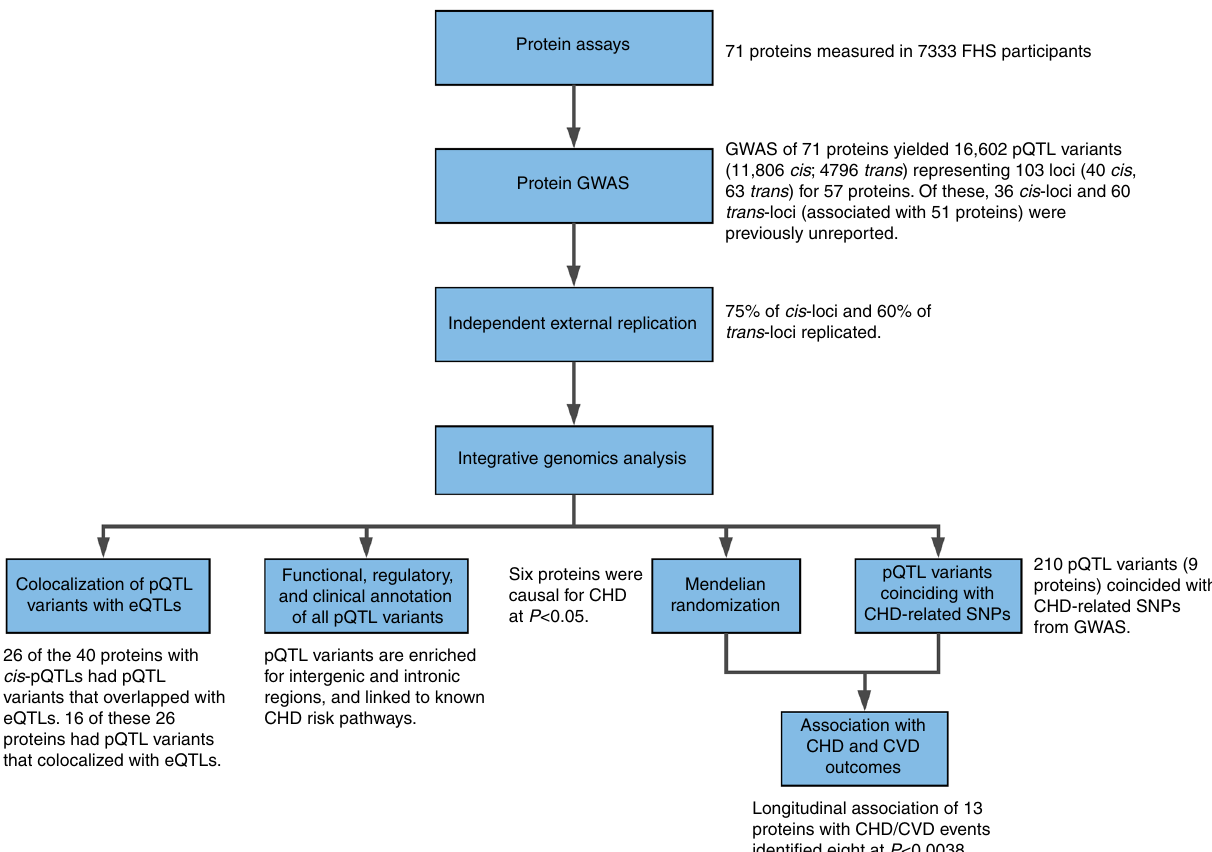
Fig. 1 Flowchart of Study Design. (1) Selection and measurement of 71 high-value plasma proteins for atherosclerotic CVD via multiplex immunoassays in 7333 FHS participants, (2) GWAS of the 71 proteins in 6861 FHS participants to identify genome-wide signi fi cant pQTL variants, (3) independent external replication of sentinel pQTLs in INTERVAL, KORA, and previous GWAS, (4) colocalization and functional enrichment analyses of the identi fi ed pQTL variants, (5) integrated analysis of pQTL variants that coincide with CHD SNPs from GWAS, (6) identi fi cation of causal proteins for CHD using Mendelian randomization, (7) association analyses of proteins from steps 5 and 6 with risk for new-onset CHD/CVD events in 3520 FHS participants 50 years of age or older with available long-term follow-up. CHD coronary heart disease, CVD cardiovascular disease, FHS Framingham Heart Study, GWAS genome-wide association study, pQTL protein quantitative trait locus, SNP single-nucleotide